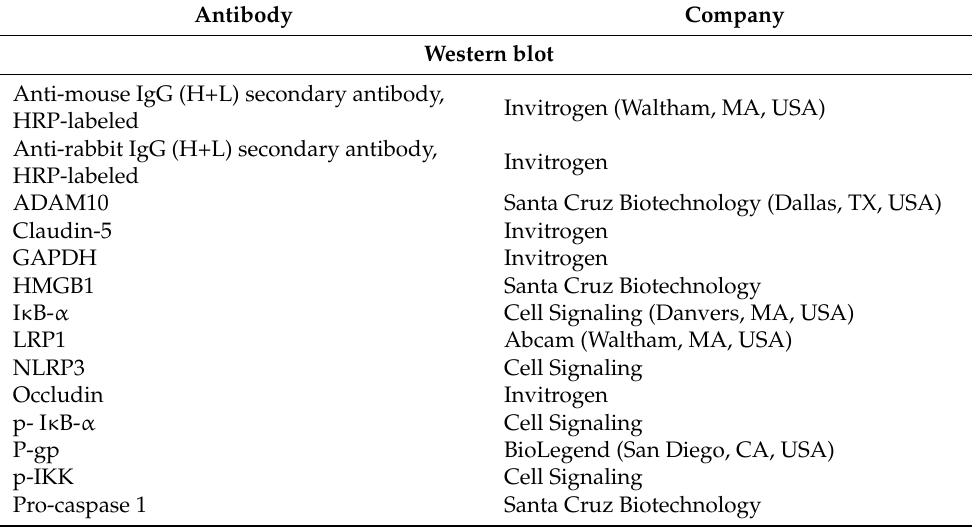
Table 1. List of